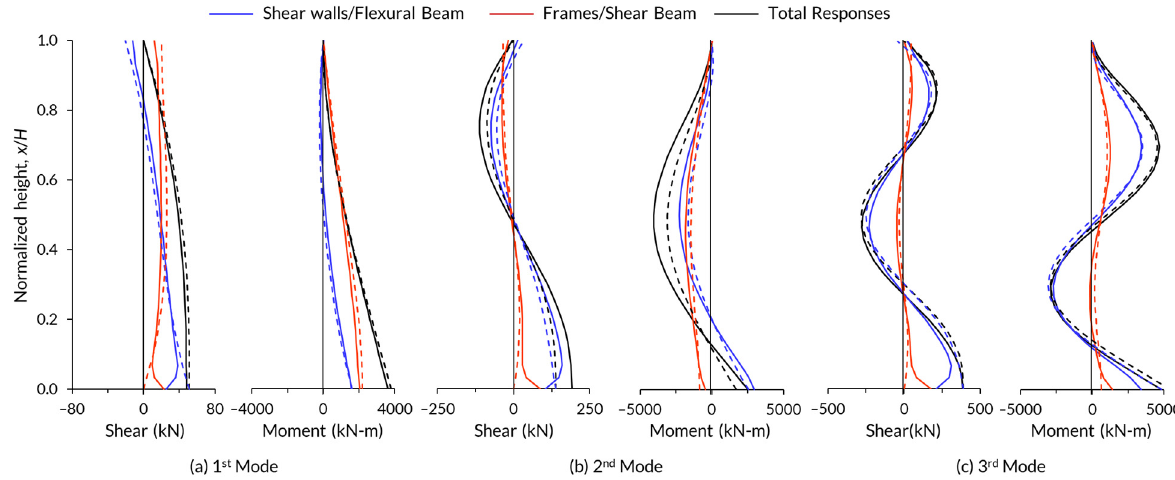
Figure 4. Deformation responses of buildings S1 and B1 in the x direction.